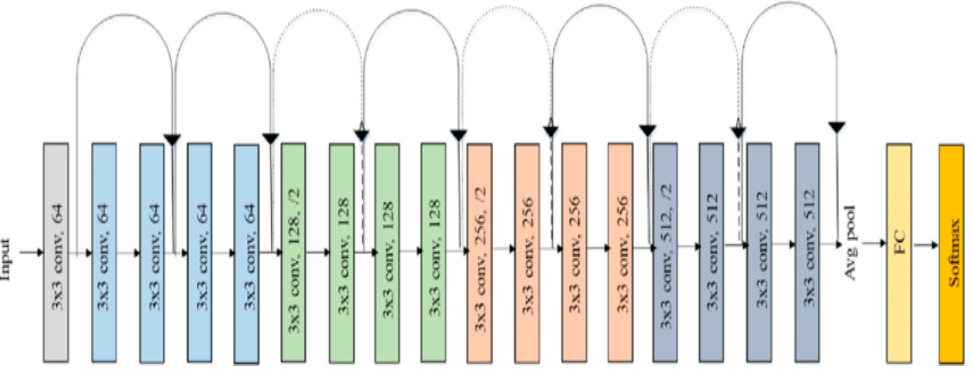
Figure 8. ResNet architecture.